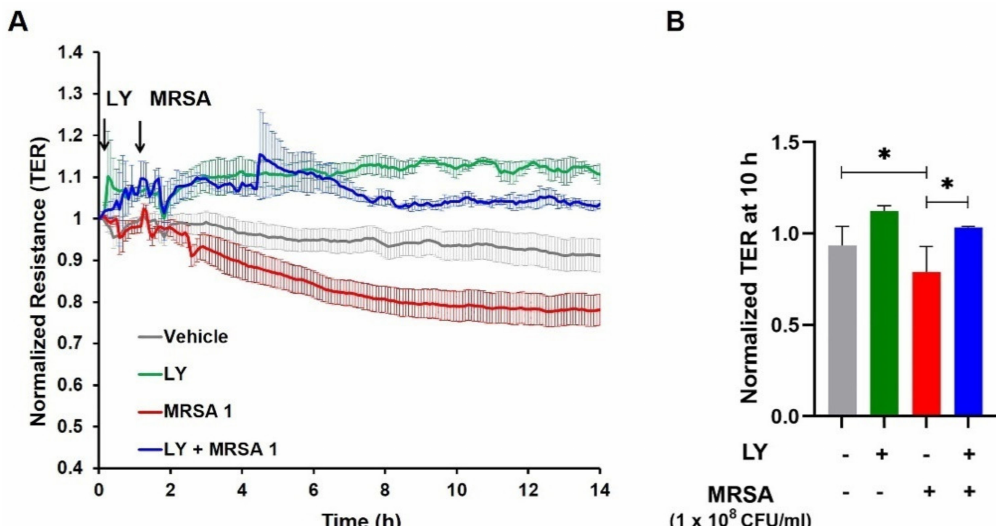
Figure 2. sPLA 2 inhibitor, LY311727, attenuates HK-MRSA-induced lung endothelial barrier disruption. HPAEC were pre-treated with LY311727 (100 µ M, 1 h) and challenged with HK-MRSA (1 × 10 8 CFU/mL). ( A ): Transendothelial electrical resistance (TER) values were recorded over time. ( B ): Normalized TER values at the 10-h time point. * p < 0.05. n = 3–16/condition.